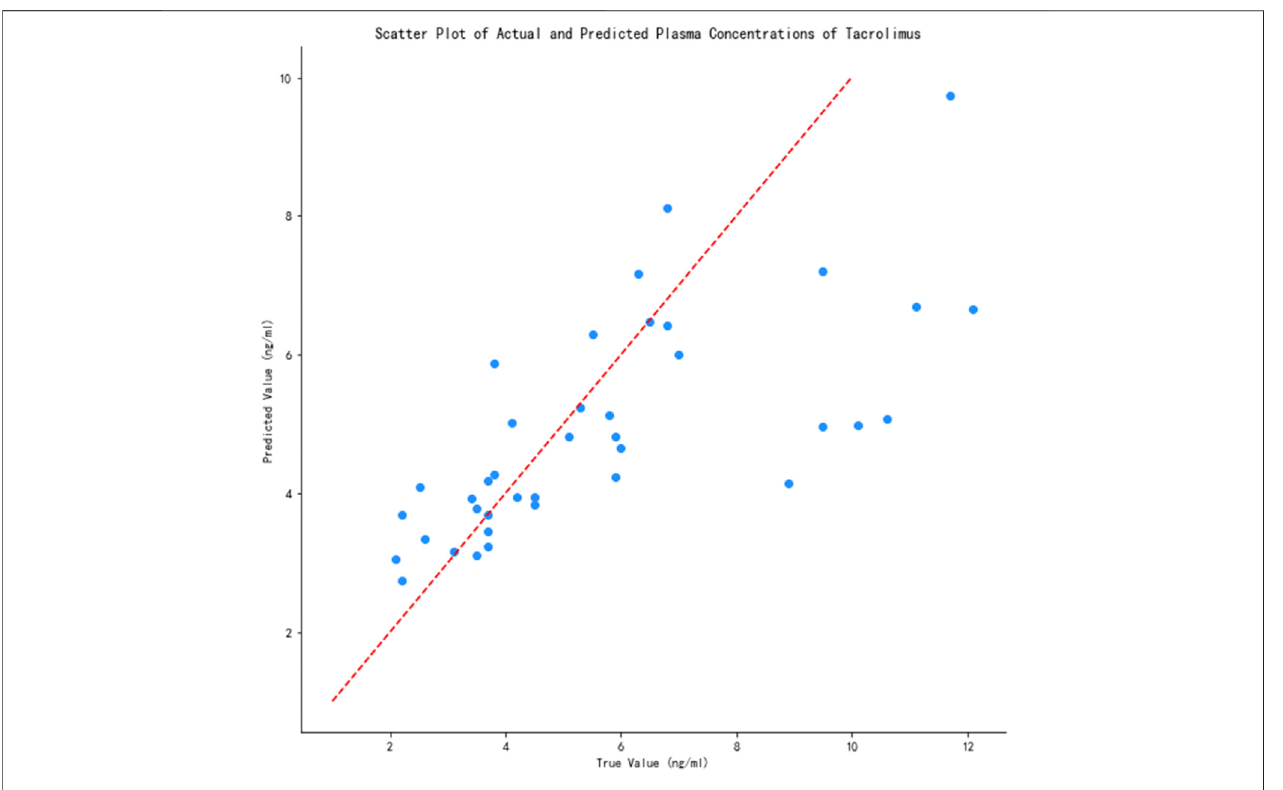
FIGURE 3 | Scatter plot of actual and predicted tacrolimus TDM